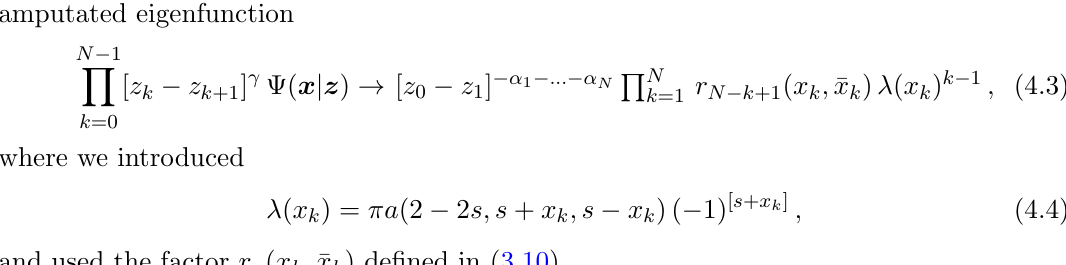
1. (2) Reduction of the diagram for y k (cid:0)